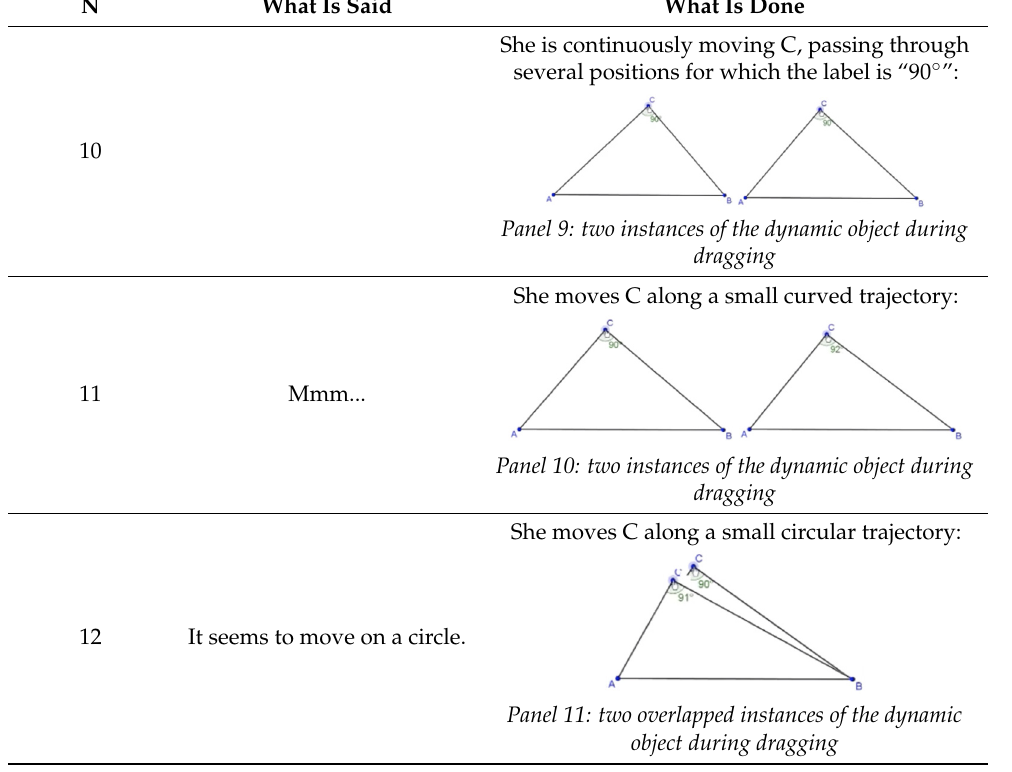
Table 8. Main elements from the analysis of Excerpt